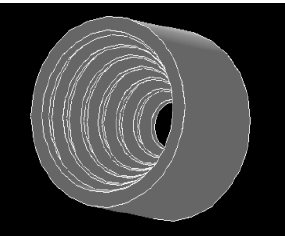
Figure 5. Backscatter structure.